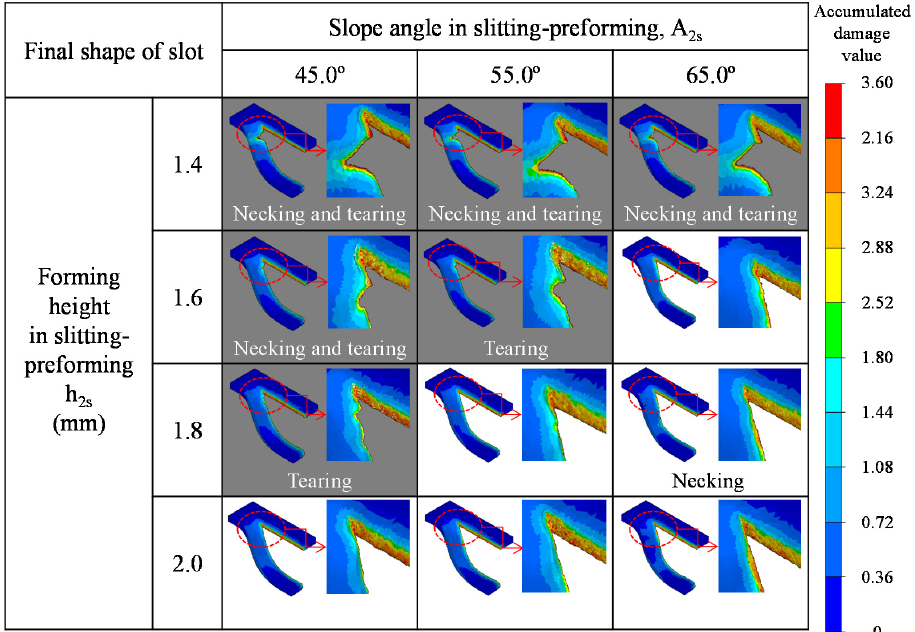
Figure 12. Deformed shapes in the slitting-preforming simulation according to the slope angle and forming height.